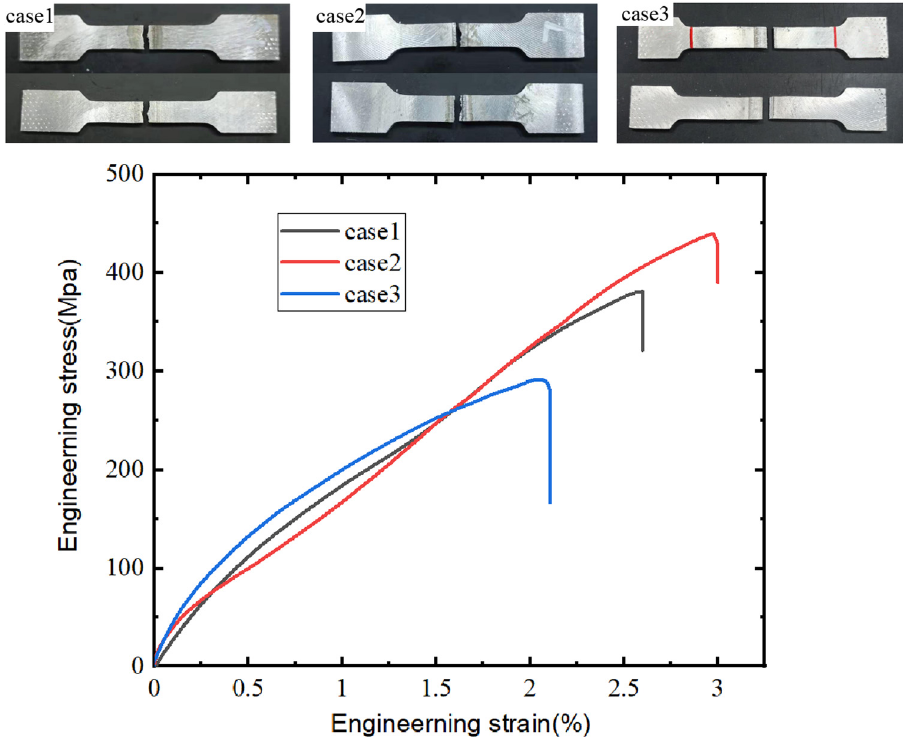
Figure 11: Stress – strain curve for di ff erent